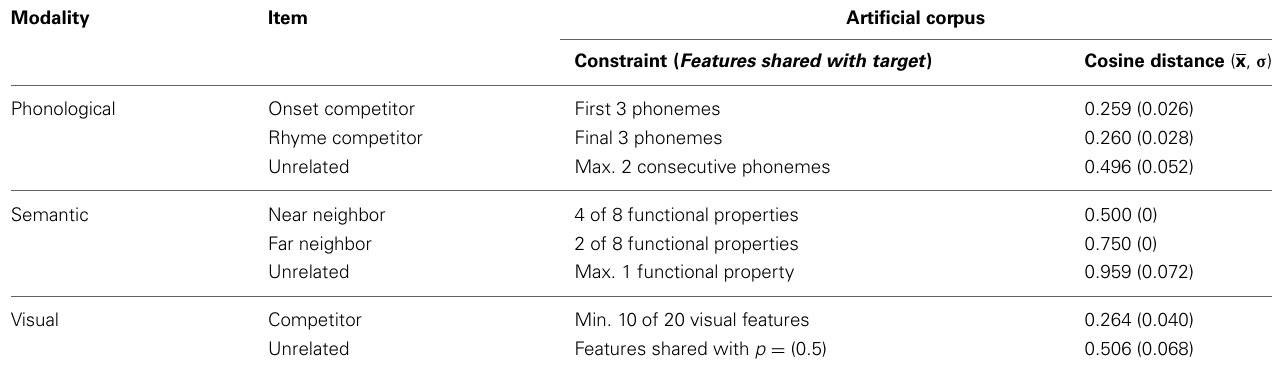
Table 1 | Controls used in the construction of artificial corpora and mean cosine distance calculated between targets, competitors and unrelated items all six randomly generated corpora used to train and test